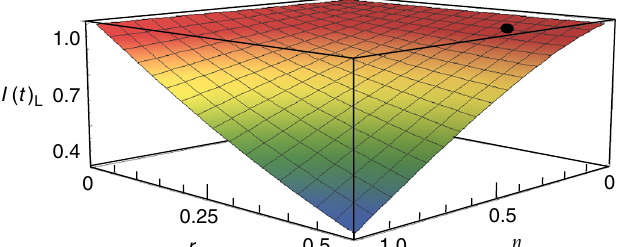
Fig. 2 The dependence of combinations of normalized quantum correlation variances among three released submodes after a storage time of 1000 ns on the squeezing parameter r of three DOPAs and the total mapping ef fi ciency η , where the gains g ′ L1 (cid:2) L3 are taken as the optimal gain g ′ opt The dot corresponds the experimental result of I ( t ) L = 0.96 ± 0.01,